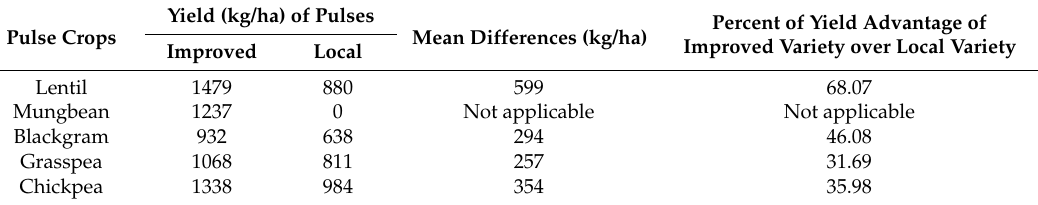
Table 2. Yield advantages of improved pulses varieties over traditional ones.